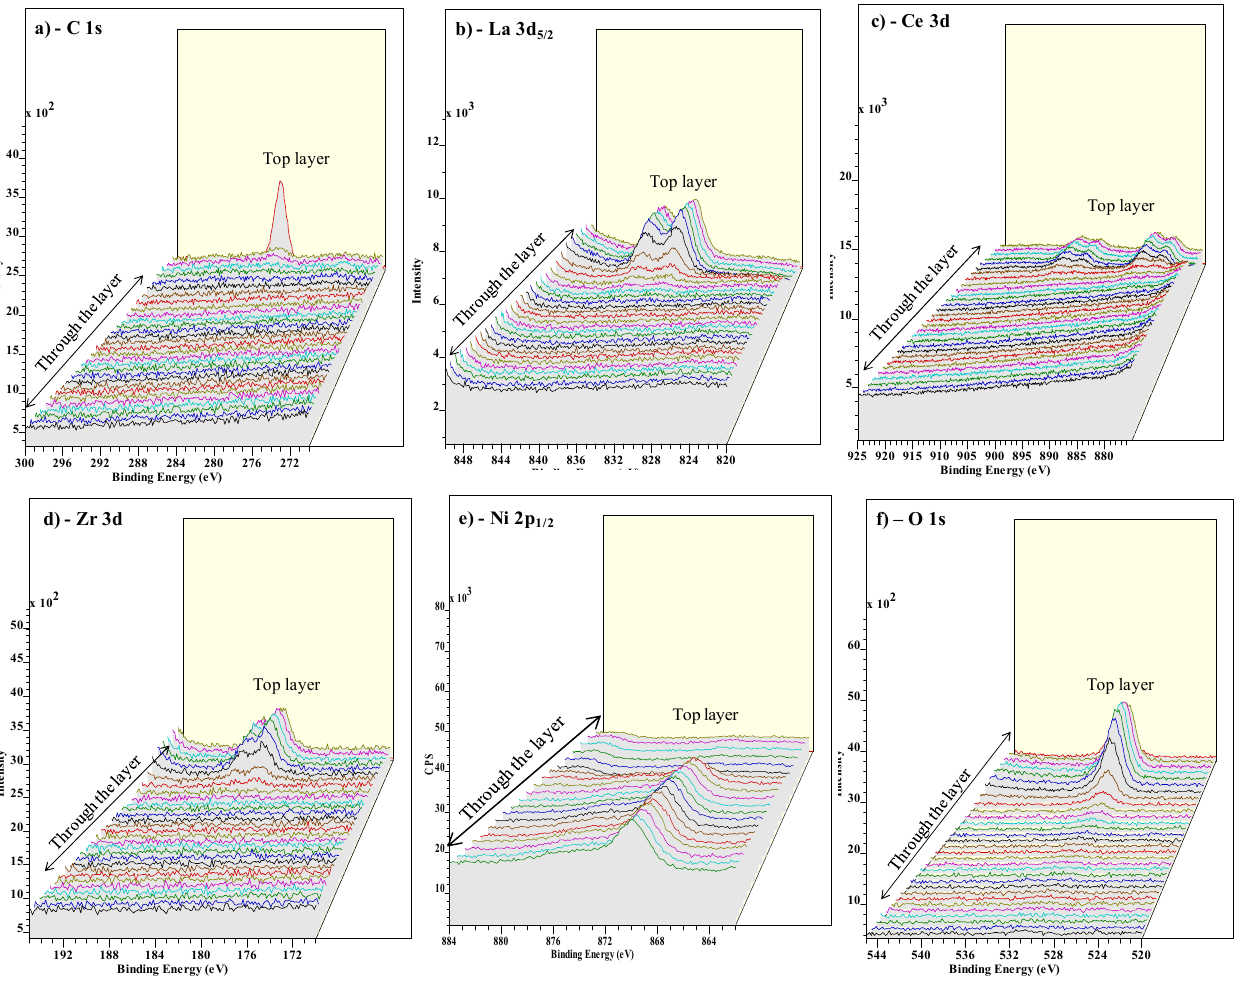
Ce Zr O 0.50 0.40 0.10 y